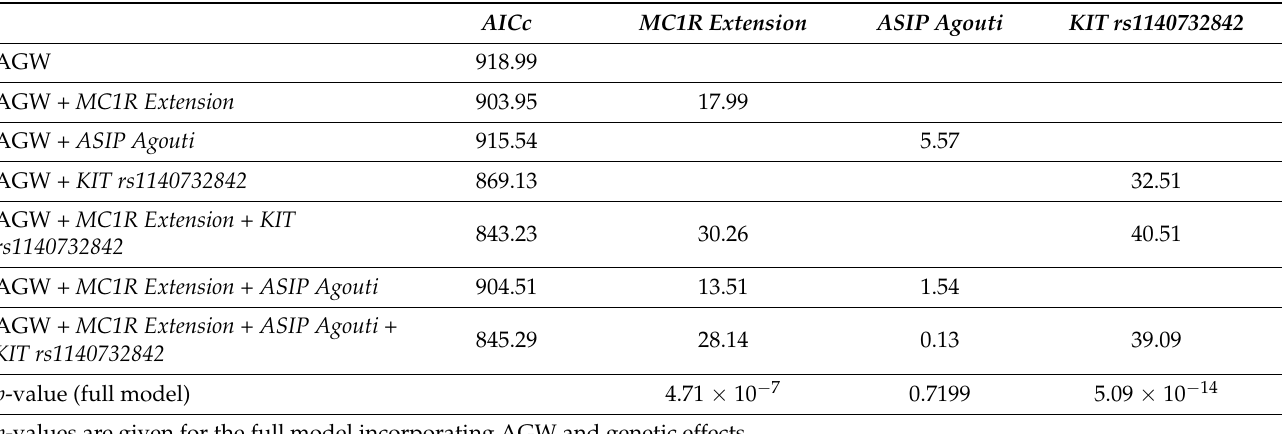
Table 1. Effect sizes of MC1R Extension , ASIP Agouti and KIT rs1140732842 loci on AGW ( n = 135 horses) using binomial